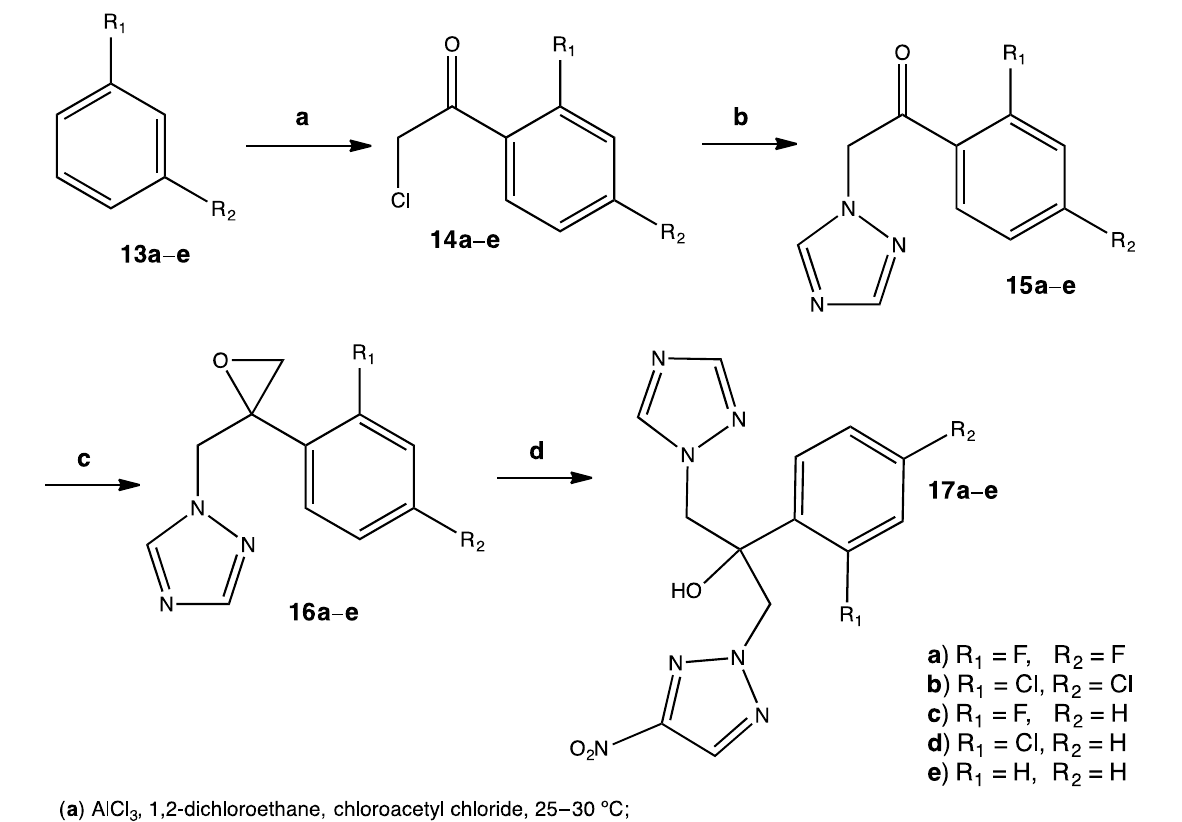
Figure 7. The presence of a nitrotriazole moiety in the fluconazole derivatives enhances antifungal properties [29].